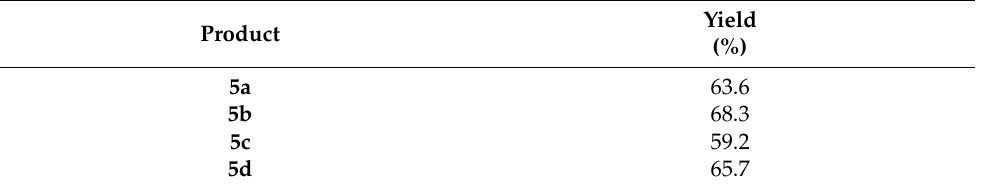
Table 7. Synthetic yields of 5a , 5b , 5c and 5d